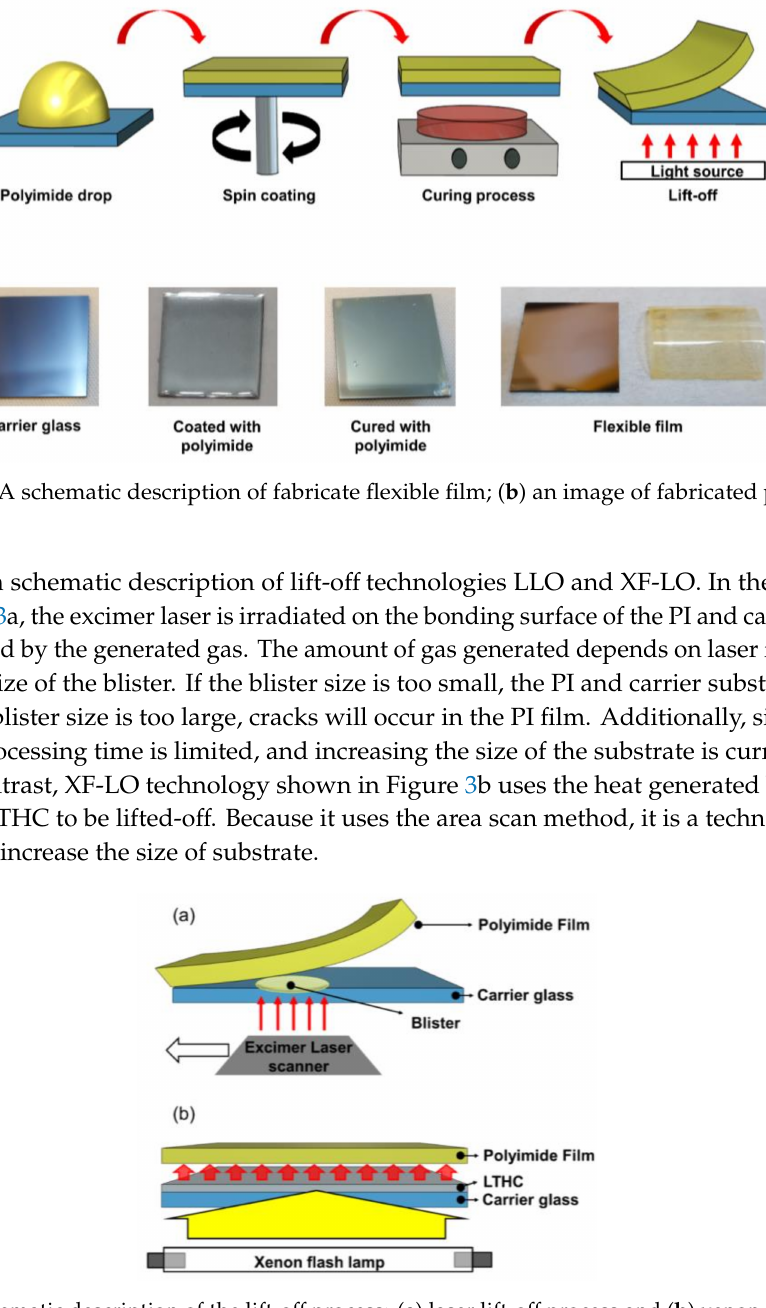
Figure 3. Schematic description of the lift-o ff process: ( a ) laser lift-o ff process and ( b ) xenon flash lamp lift-o ff (XF-LO)